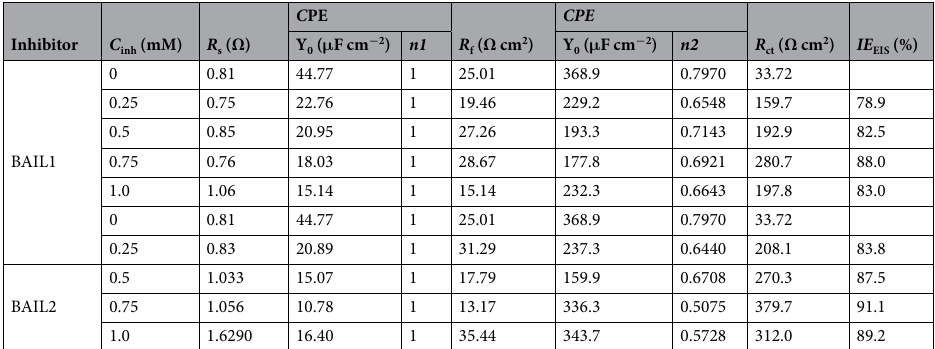
Table 1. Electrochemical impedance parameters for carbon steel in 0.5 M HCl solution without/with different concentrations of BAIL1 and